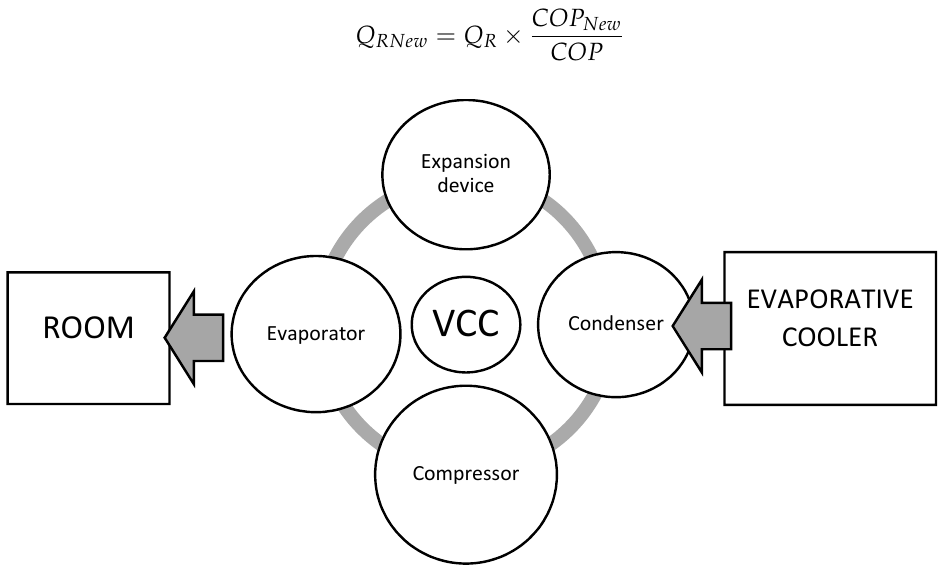
Figure 2. Vapor compression system with evaporative cooling of condenser. Fig.2 Vapor compression system with evaporative cooling of condenser